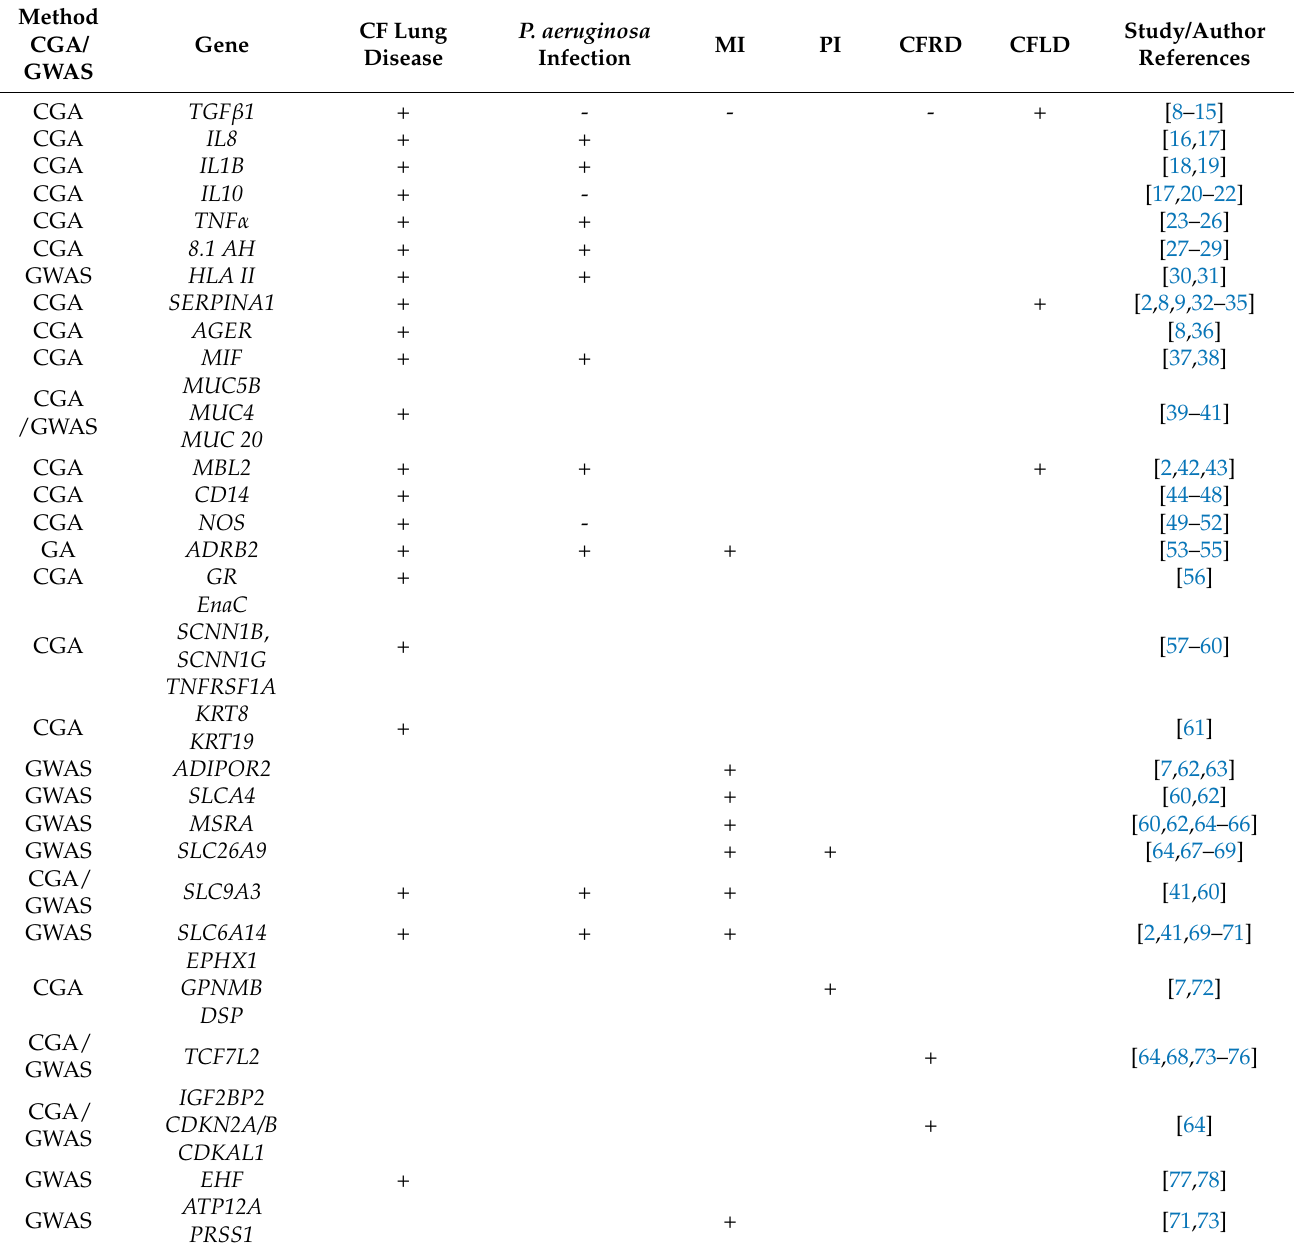
Table 1. Phenotype modifier gene studies (lung disease and associated comorbidities) in patients with cystic fibrosis.